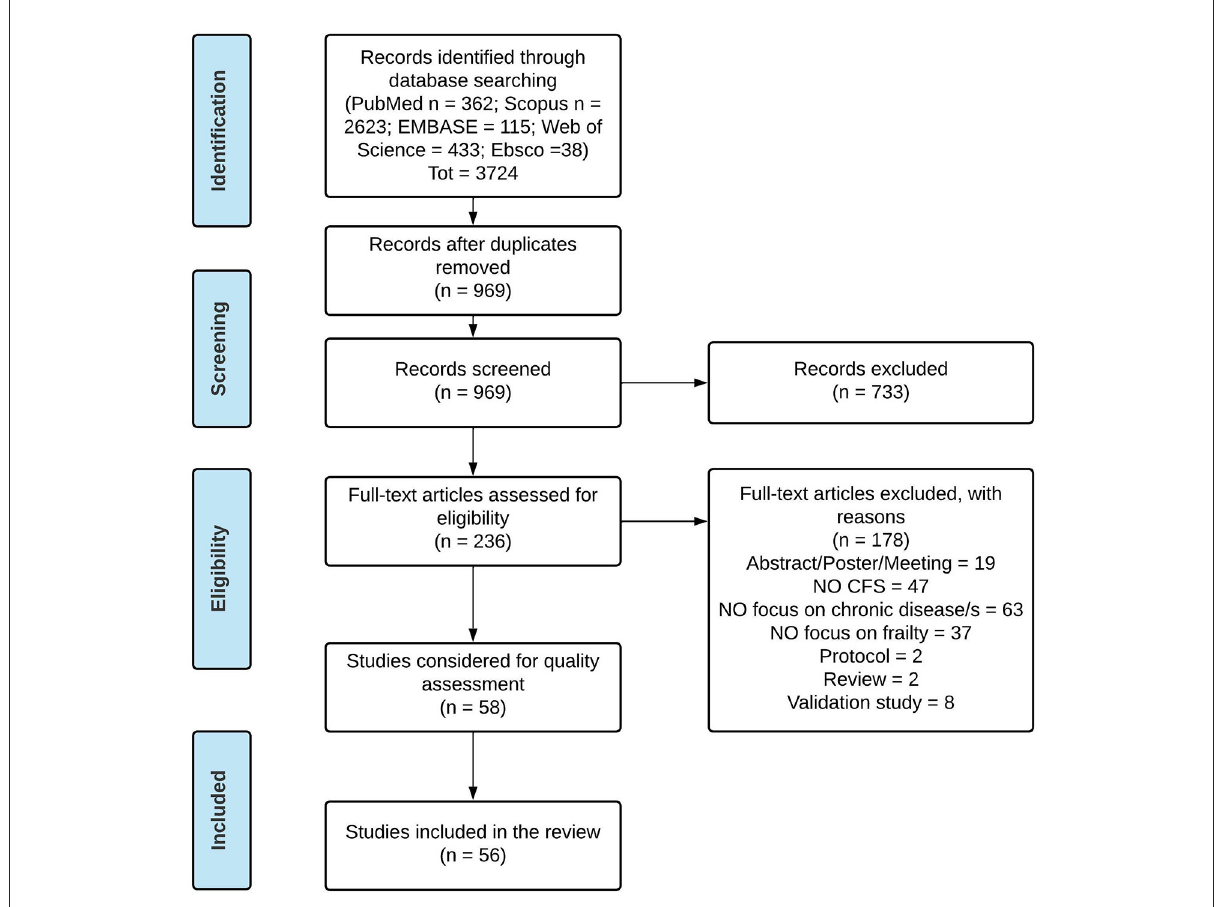
FIGURE1 PRISMA Flow Diagram of the systematic